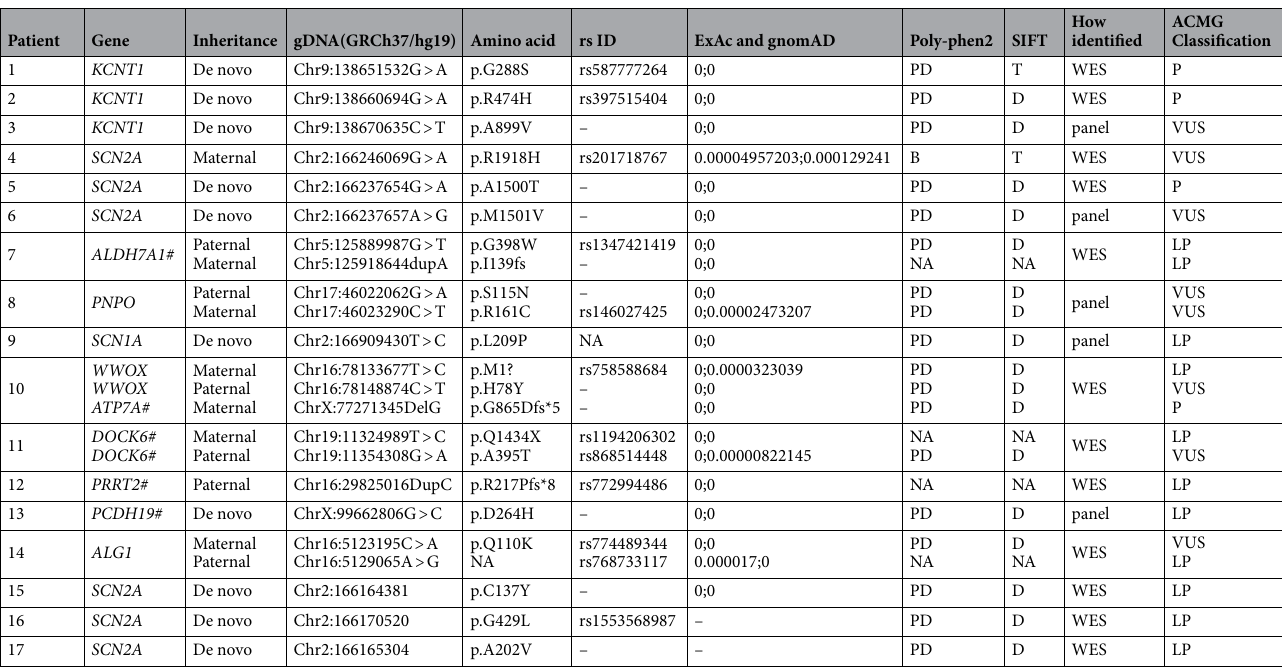
Table 2. Variants in novel MMPSI genes and in silico analysis of pathogenicity. ACMG, American College of Medical Genetics; B, Benign; CMA, clinical microarray; CNV, Copy Number Variant; D, Deleterious; ExAC, Exome Aggregation Consortium; gnomAD, Genome Aggregation Database; LP, likely pathogenic; MMPSI, Malignant migrating partial seizures of infancy; NA, Not applicable: when the gene mutation is nonsense or frameshift mutation, the software can not predict the pathogenicity of the mutation; P, pathogenic; PD, Possibly Damaging; SIFT, Sorting Intolerant from Tolerant; T, Tolerated; VUS, variant of unknown significance; WES, Whole Exome Sequencing; #: novel